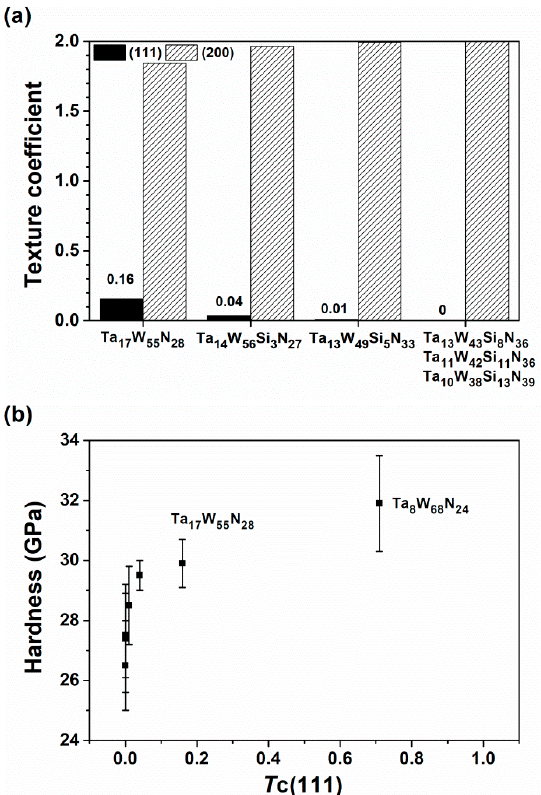
Figure 8. ( a ) Texture coefficient and ( b ) its relationship to the hardness of the TaWSiN films.